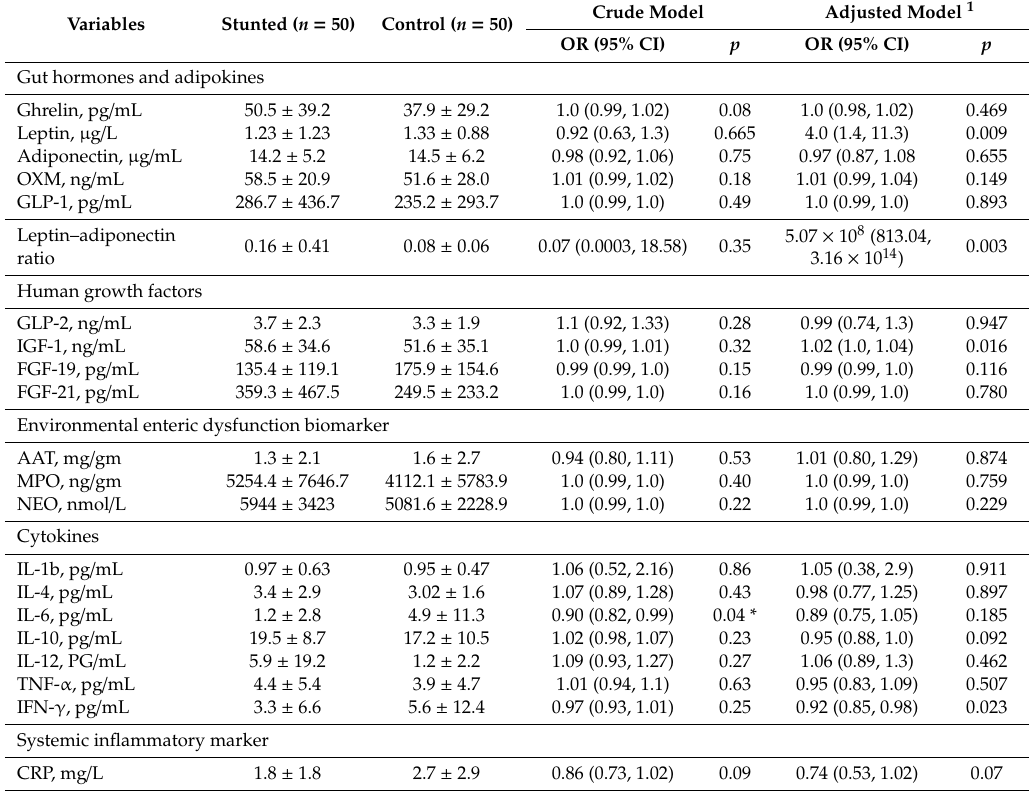
Table 3. Association of di ff erent biomarkers with child stunting at